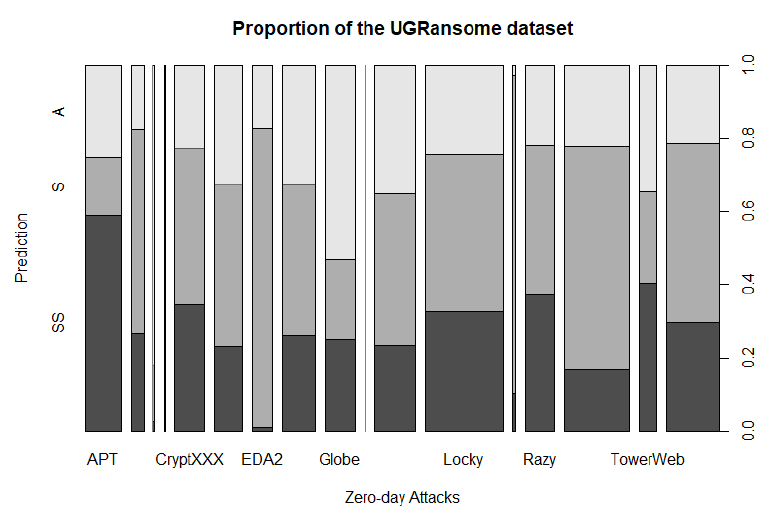
Figure 40. Evaluation of the UGRansome dataset.